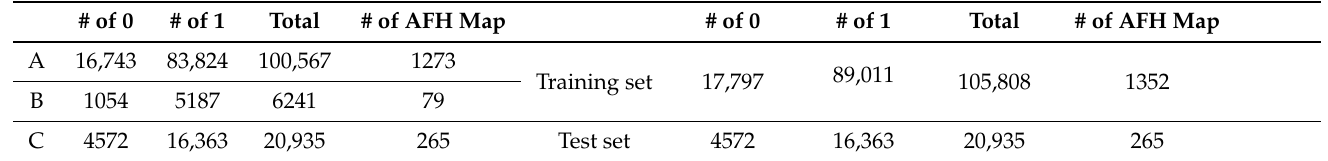
Table 1. Statistics of the dataset collected in the testbed.